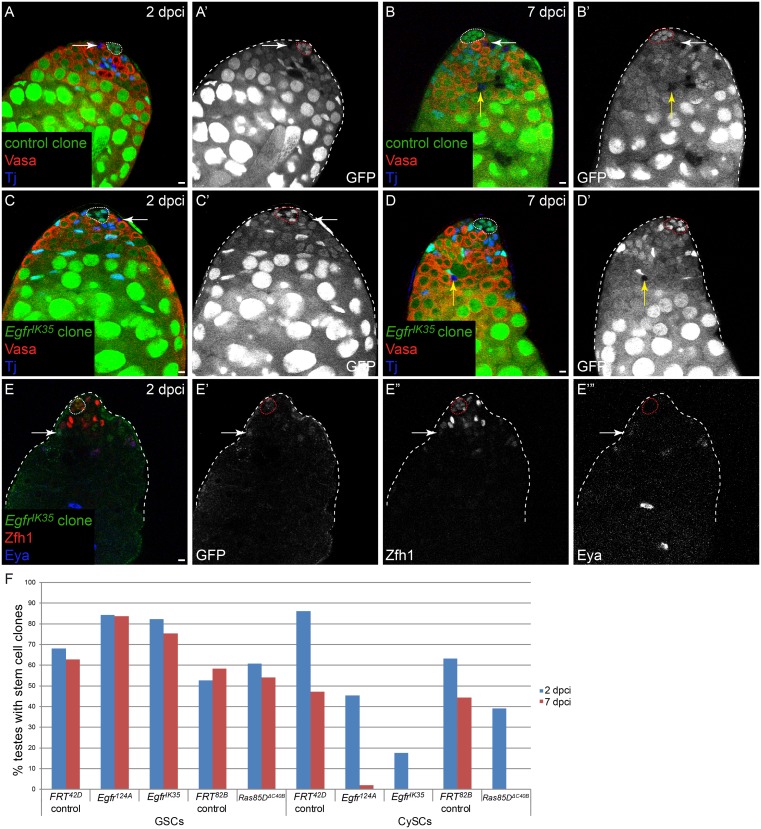
MAPK is required autonomously for CySC self-renewal.In A-D, clones are marked by the absence of GFP and in E, MARCM clones are marked by the presence of GFP. A) Testis with a control CySC clone (arrow) at 2 dpci. B) Testis with a control CySC clone at 7 dpci (B,B’, white arrow). Yellow arrow denotes a labeled differentiating cyst cell. C) Testis with an Egfr mutant clone (arrow) at 2 dpci, indicating that clones of this genotype can be induced. D) At 7 dpci, Egfr mutant CySC clones cannot be recovered. However, the differentiating offspring of these mutant clones are observed (yellow arrow). E) At 2 dpci, an Egfr mutant CySC (arrow) has already begun to differentiate as it has low levels of Zfh1 and has started to express Eya. F) Graph showing clone recovery rates for negatively-marked clones (mutant GSCs and mutant CySCs) at 2 and 7 dpci. See Table 1 for “n” values. Loss of Egfr or Ras does not affect the maintenance of GSCs. By contrast, CySC clones lacking either gene have reduced clone recovery rates at 2 dpci and are not maintained at 7 dpci. Vasa is red and Tj is blue in A-D. Zfh1 is red and Eya is blue in E. The hub is outlined by a dotted line. Scale bar = 5 μM.